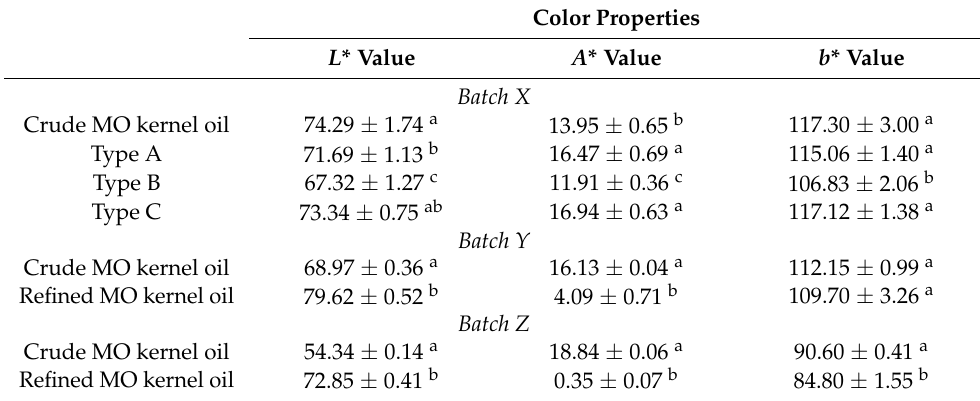
Means ± standard deviation followed by the same alphabet in each column of each MO kernel oil batch are not significantly different ( p > 0.05) as determined by the analysis of variance (ANOVA) with Tukey’s Multiple Comparison Test, and by the two-sample t -test. - Types of bleaching earth (Batch X): Type A and Type B (acid-activated); Type C (neutral). - The degumming step was carried out by using acid degumming. -